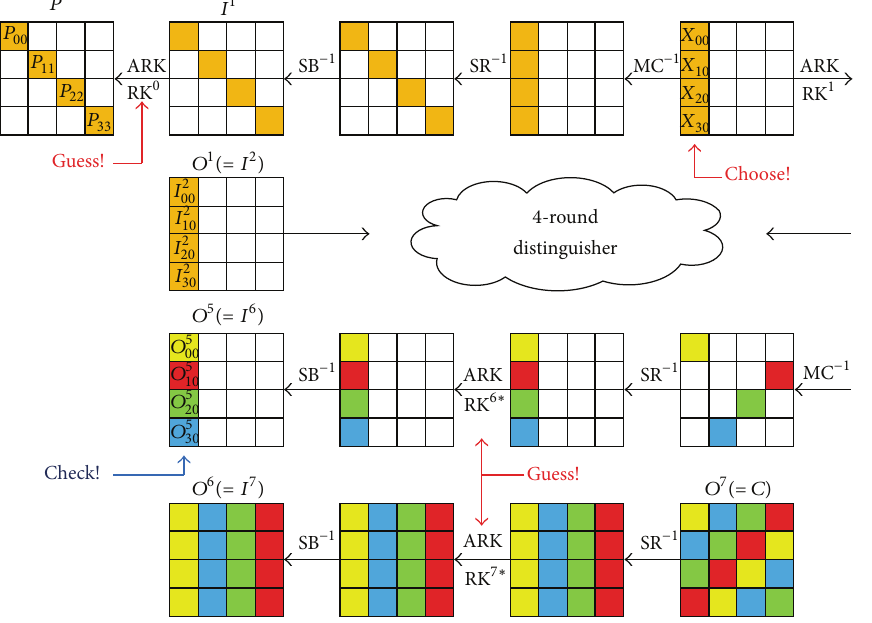
Figure 2: The attack procedure on AES- 192 / 256